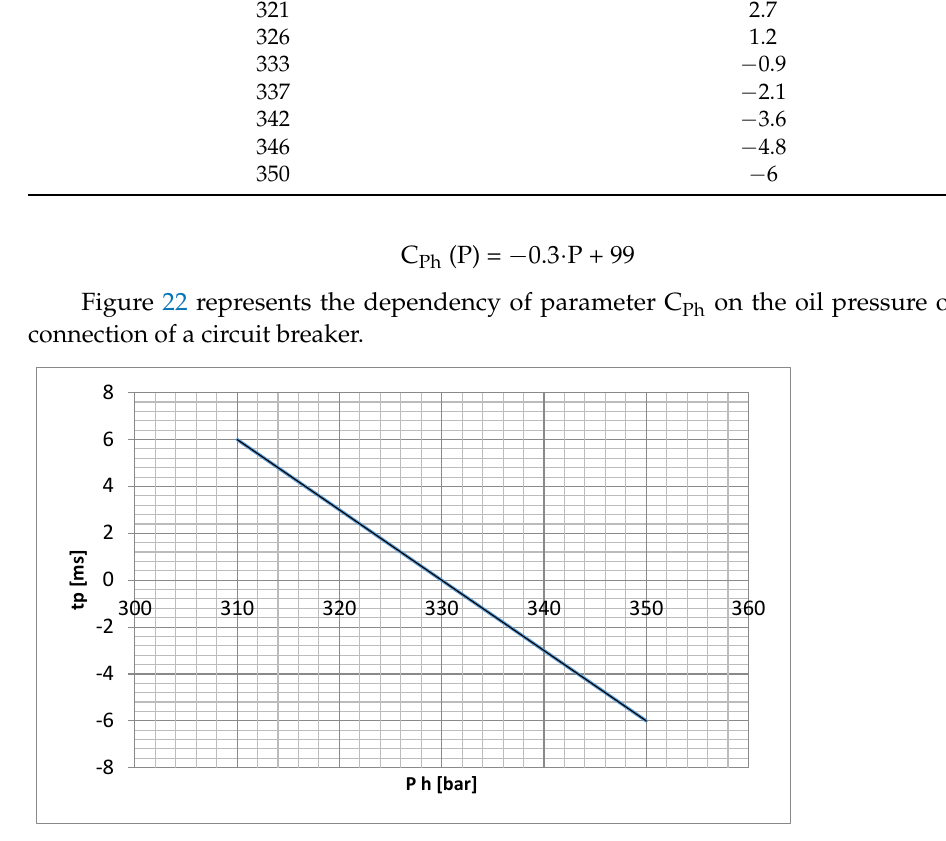
Figure 23. The simulation of monophasic power supply system on the connecting process of the circuit breaker on t 1 = t command = 5 ms. Table 10. The main parameters used in simulation of connection process of the circuit-breaker. Parameters